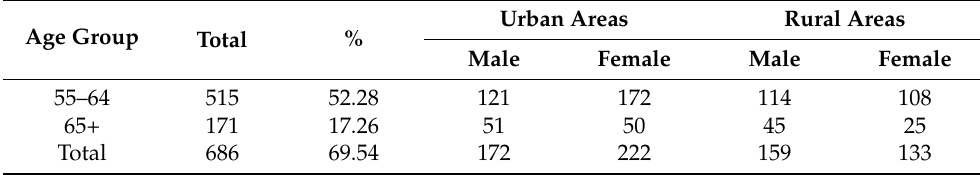
Table 4. Elderly social networks users by age and place of residence. Age Group Total